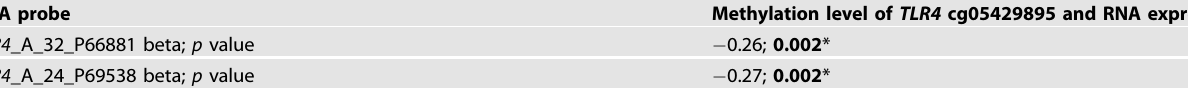
Table 5. Associations between TLR4 cg05429895 methylation levels and TLR4 RNA expression levels using two different RA probes in the Danish twin